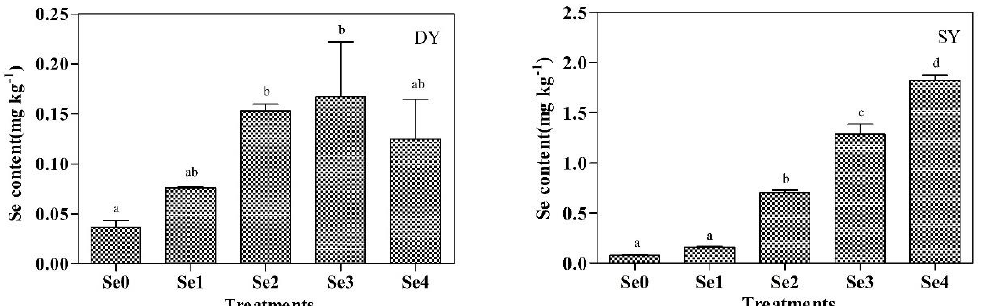
Figure 3. Effects of Se fertilizer application on the Se content in maize grains at locations DY and SY. Note: Se0, Se fertilizer application 0 g ha − 1 ; Se1, Se fertilizer application 75 g ha − 1 ; Se2, Se fertilizer application 150 g ha − 1 ; Se3, Se fertilizer application 225 g ha − 1 ; Se4, Se fertilizer application 300 g ha − 1 . Different lowercase letters in the same column indicate significant differences among different treatments ( p < 0.05).